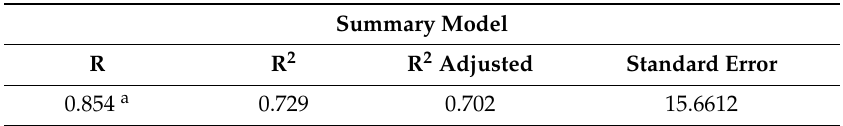
Table 14. Determination coe ffi cients for wheel-tracking test and second modulus of PLT ( Φ 600mm) at